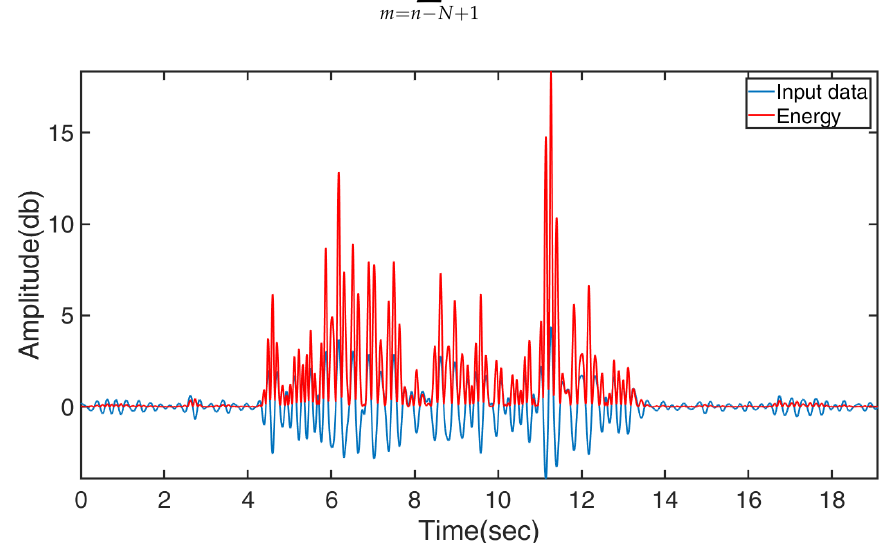
Figure 2. A sample of CSI sequence and calculated